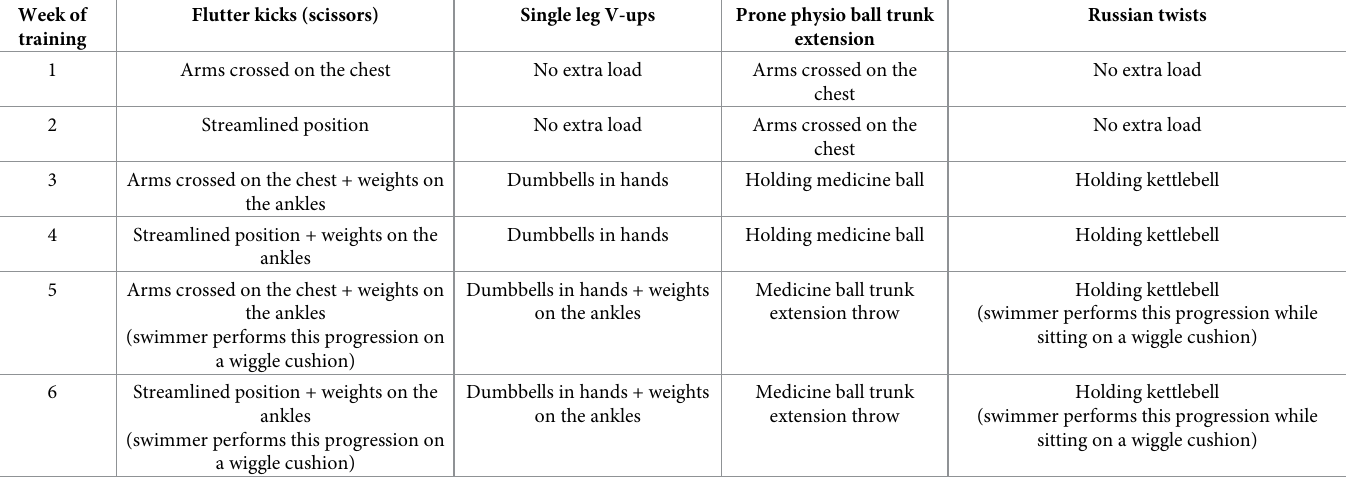
Table 2. A brief description of the exercises of SCMT and their progression over a 6-week training program. Week of